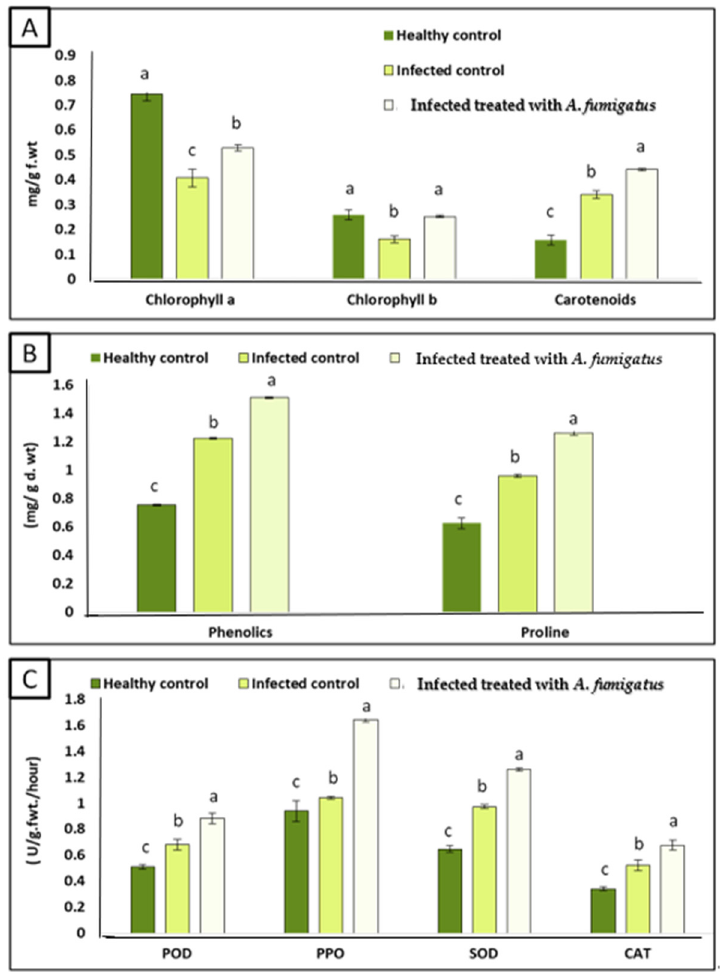
Figure 7. Effect of A. fumigatus on ( A ) photosynthetic pigments (chlorophyll a, chlorophyll b and carotenoids) (mg/g fresh weight), ( B ) phenolics, proline (mg/g dry weight) and antioxidant en- zymes ( C ) activity (POD, PPO, SOD, and CAT) (unit/g fresh weight/hour). Data are expressed as means ± standard deviations of triplicate assays. The different alphabetic superscripts in each item are significantly different ( p < 0.05).